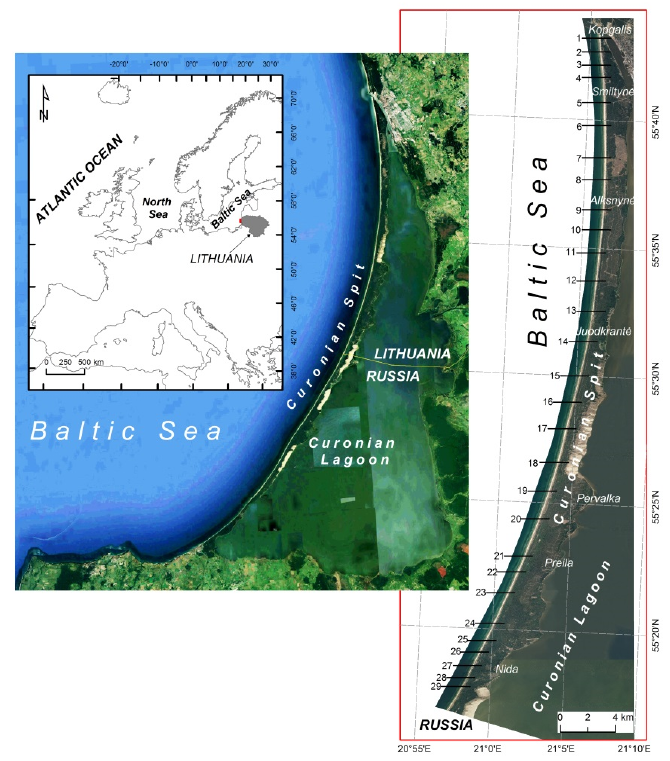
Figure 1. Location map. The black lines and numbers represent cross-shore profiles (Google Earth, earth.google.com / web /